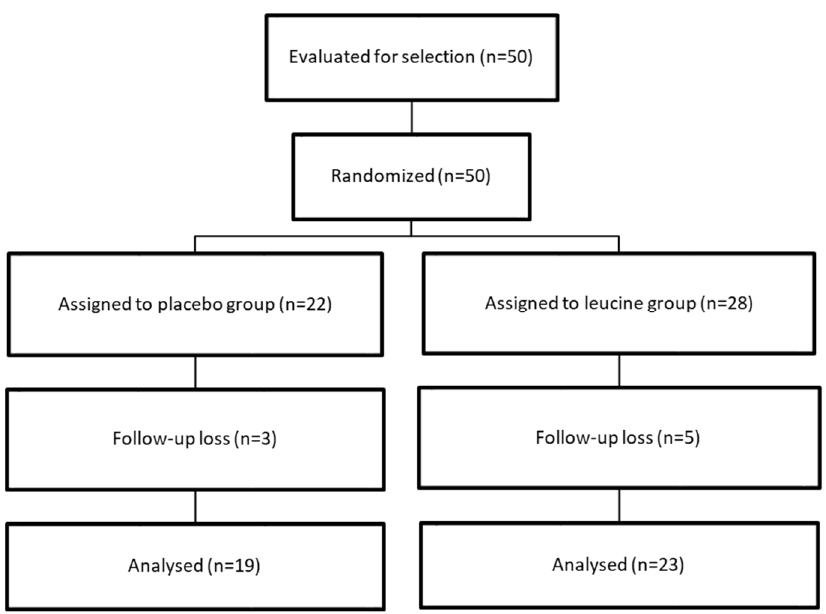
Figure 1. Study Figure 1. Study flowchart.